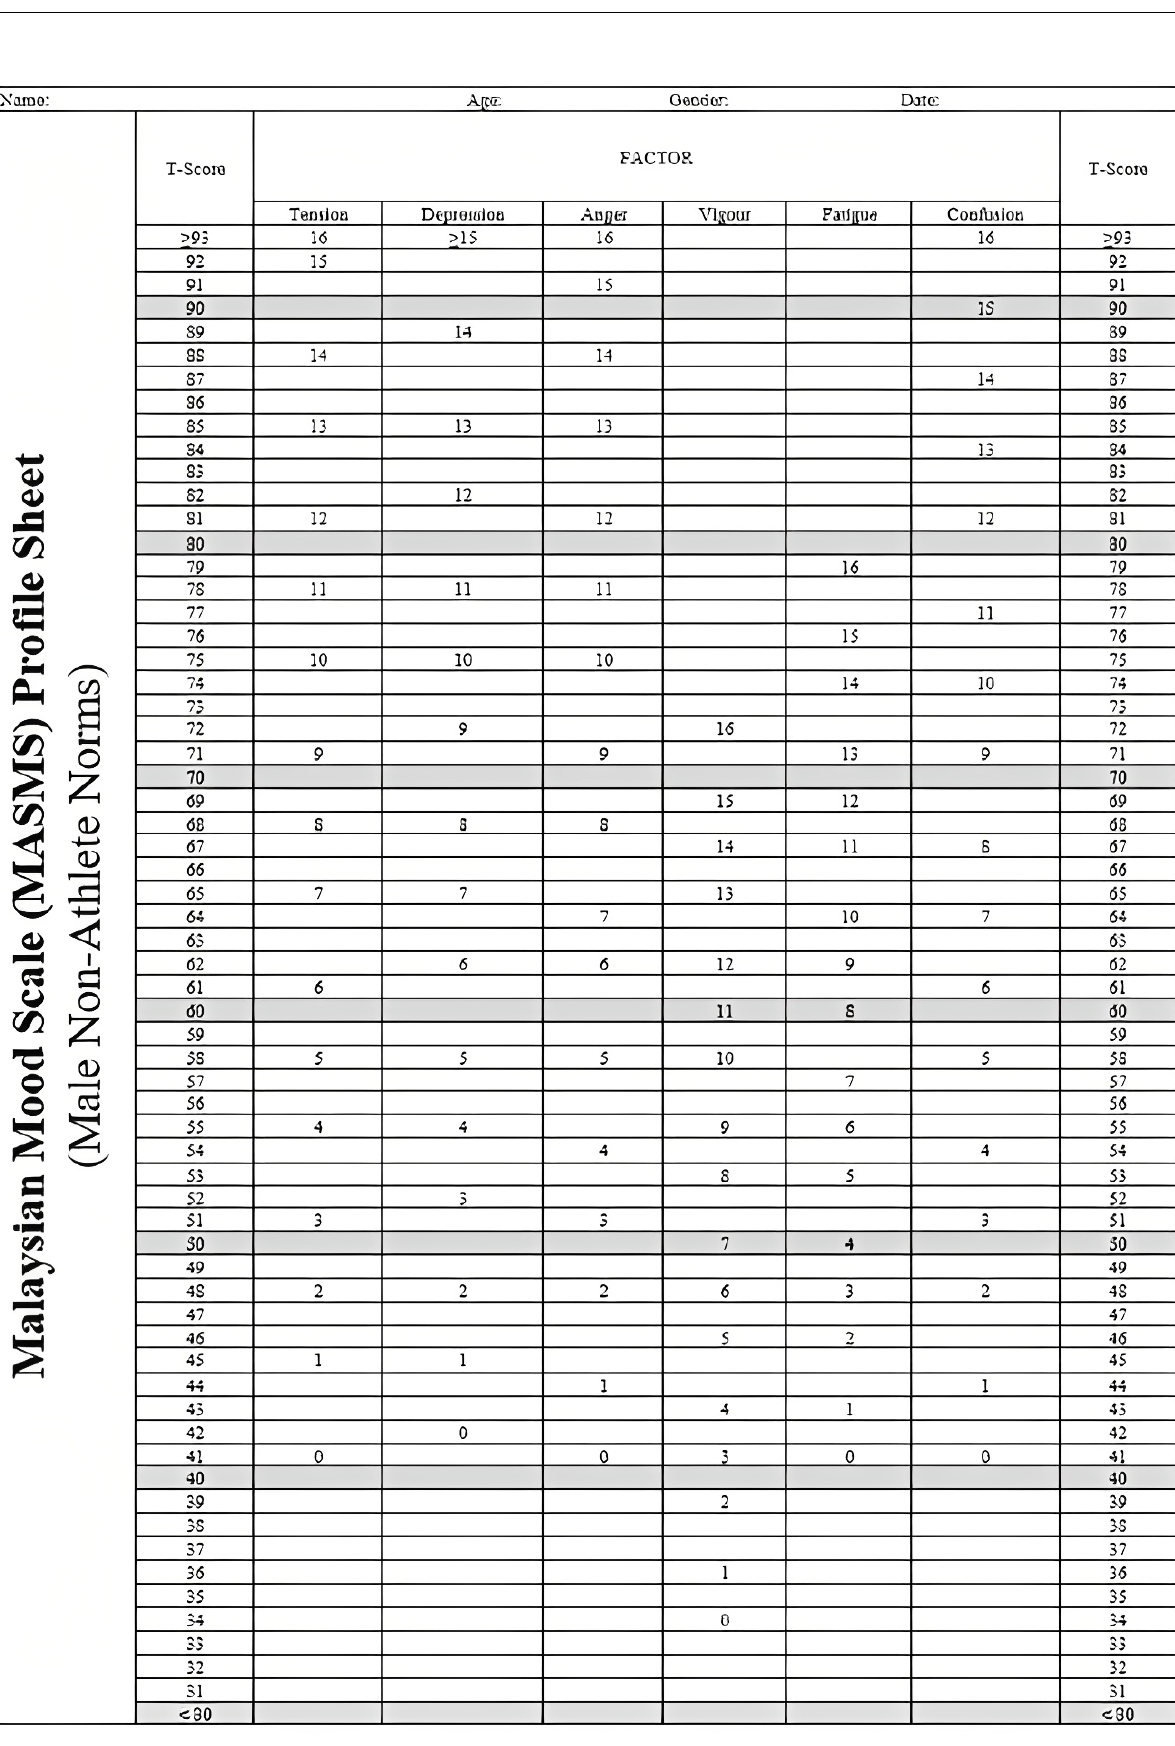
Figure A4. MASMS profile sheet (male non-athlete norms).